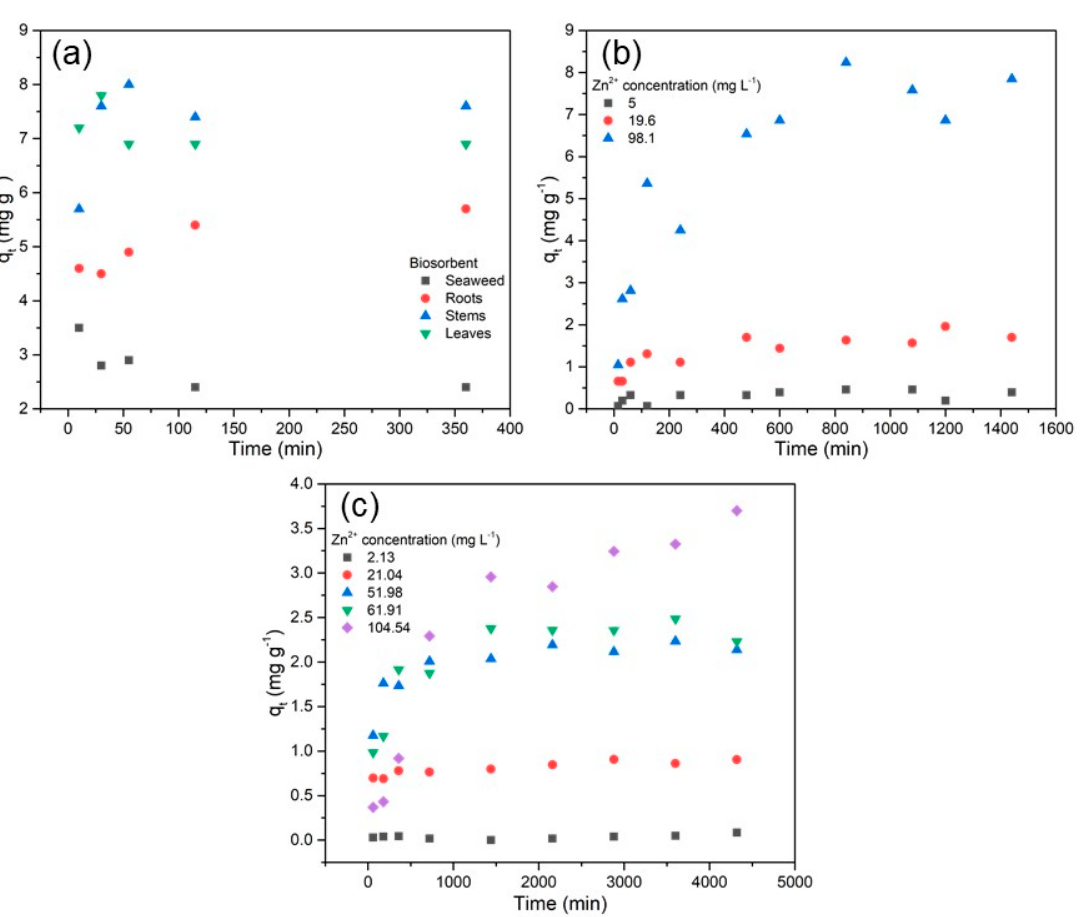
Figure 3 Adsorption curves of the Zn 2+ ion for the systems: ( a ) S1-Zn—with different biosorbents [49]; ( b ) S2-Zn—with different initial concentrations of zinc [50]; ( c ) S3-Zn—with different initial concentrations of zinc [31].